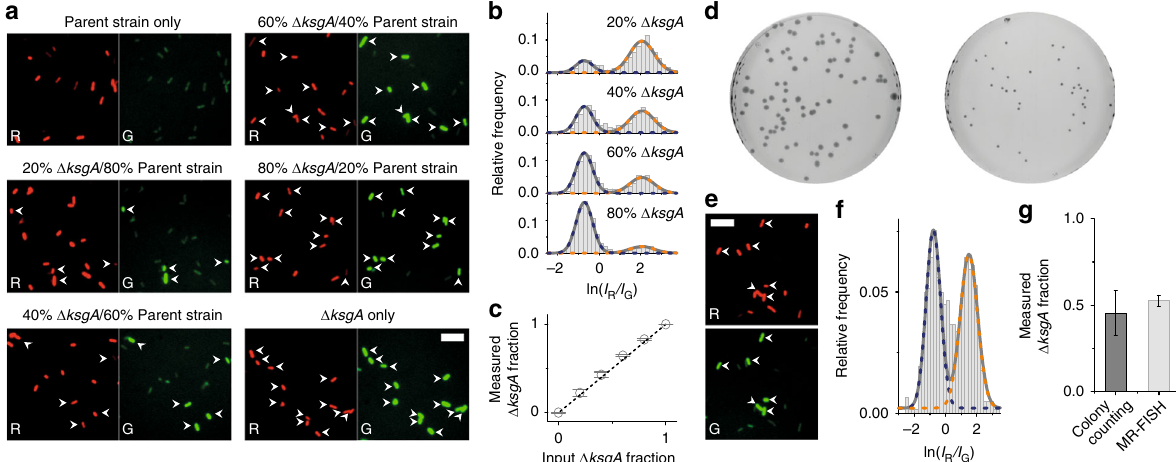
Fig. 3 Detecting heterogeneity in mixtures of bacteria with different rRNA methylation status. a False-colored red and green fl uorescence images of pure samples and mixtures of parent strain and Δ ksgA E . coli after MR-FISH. All red images are shown at one fi xed brightness and contrast, and all green images at another fi xed brightness and contrast. To guide the eye, manually selected bacteria with high green fl uorescence intensity are indicated with arrows in both red and green images. Scale bar: 10 μ m. b Histograms of two-color ratios obtained from mixtures of parent strain and Δ ksgA bacteria ( n = 1372, 1639, 1593 and 1183 cells respectively for 20%, 40%, 60% and 80% Δ ksgA ). The data are fi tted to a bimodal Gaussian distribution with centers and widths de fi ned by fi ts of MR-FISH data from pure samples of each bacterium. c Quanti fi cation of the fraction of Δ ksgA E . coli in mixtures with parent strain bacteria, based on the areas of each population extracted from the bimodal distributions of two-color ratios. The means and standard deviations of three technical replicates are plotted, while the equation of the dotted line is “ measured fraction = input fraction ” . d Growth of co-culture of parent strain and Δ ksgA E . coli on an agar plate (left) and a plate containing kanamycin (right), which selects for Δ ksgA E . coli only. e False-colored red and green fl uorescence images of co-culture after MR-FISH. Scale bar: 10 μ m. f Histogram of two-color ratios of the co-culture ( n = 625 cells), fi tted to a bimodal Gaussian distribution with centers and widths de fi ned as in ( b ). g Comparison of the fraction of Δ ksgA E . coli in co-culture as measured by colony counting and MR-FISH. The means and standard deviations from each technique are plotted ( n = 5 technical